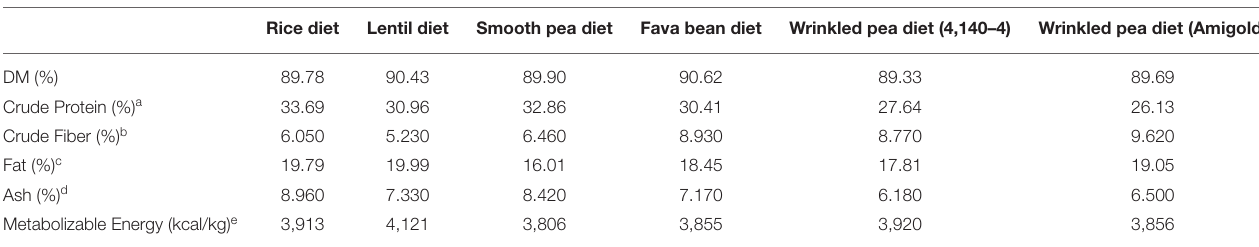
TABLE 2 | Proximate analyses of test diets after extrusion and fat coating. Rice